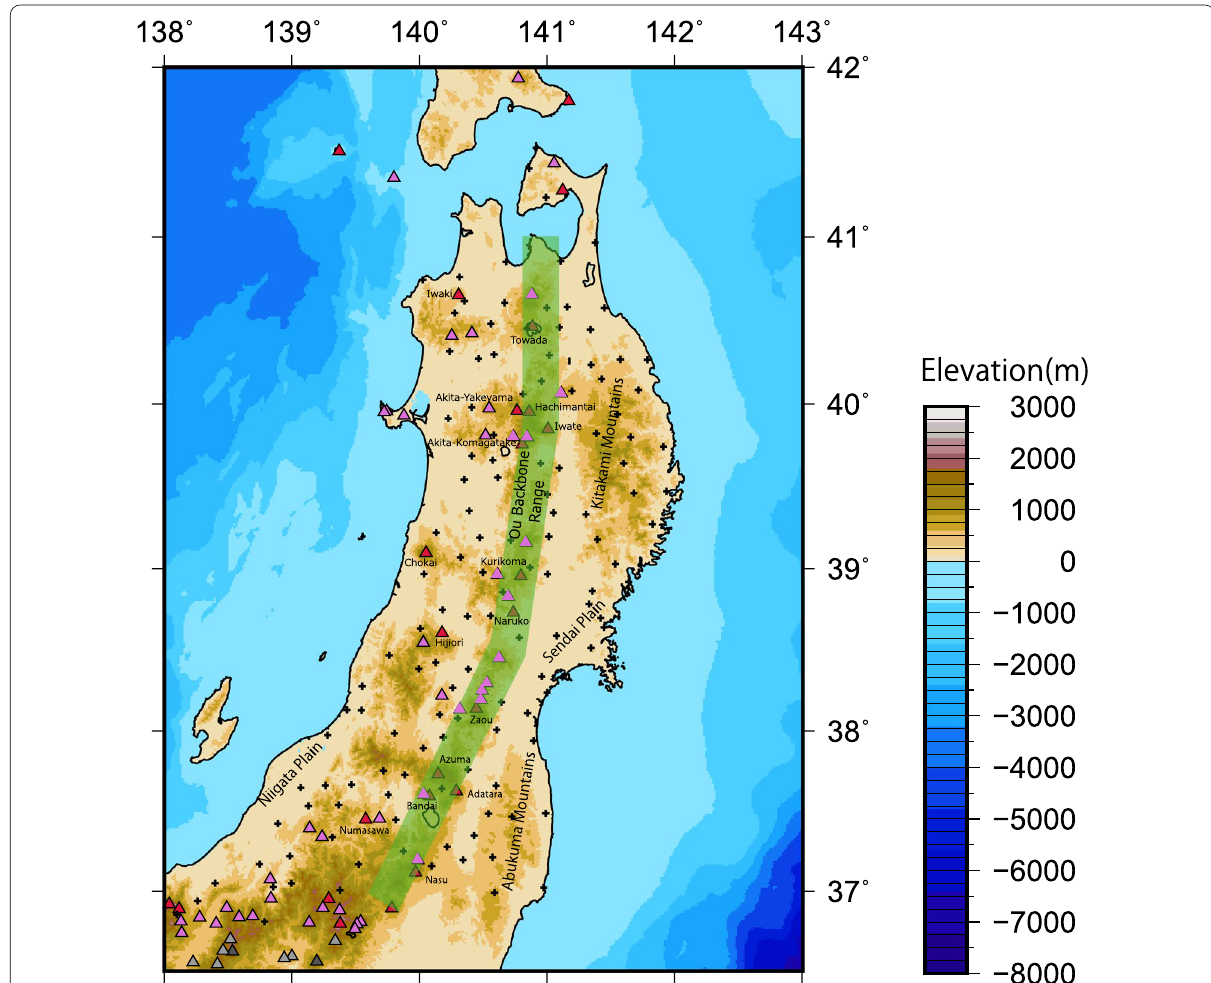
Fig. 1 Tectonic setting of the Northeastern part of Japan. Quaternary volcanoes in Northeastern Japan arc are shown by red triangles. Active volcanoes are also shown by pink triangles. The thick black cross indicates Hi-net observation sites. The red dashed line indicates the volcanic front (Yoshida et al. 2013). The green hatch area indicates the location of the Ou Backbone